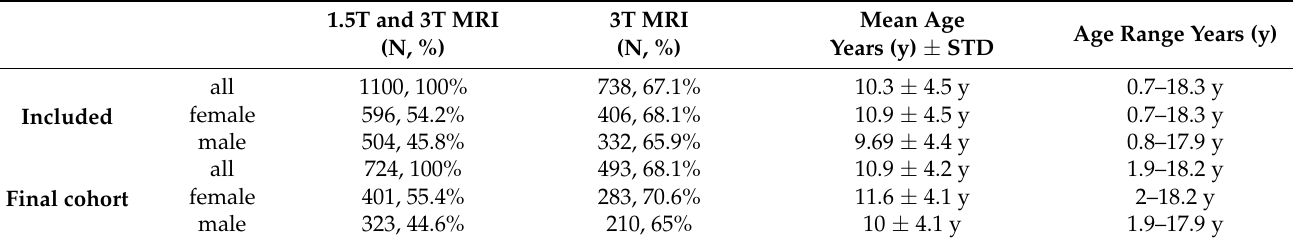
Table 1. Demographics of the children included in the volumetric data